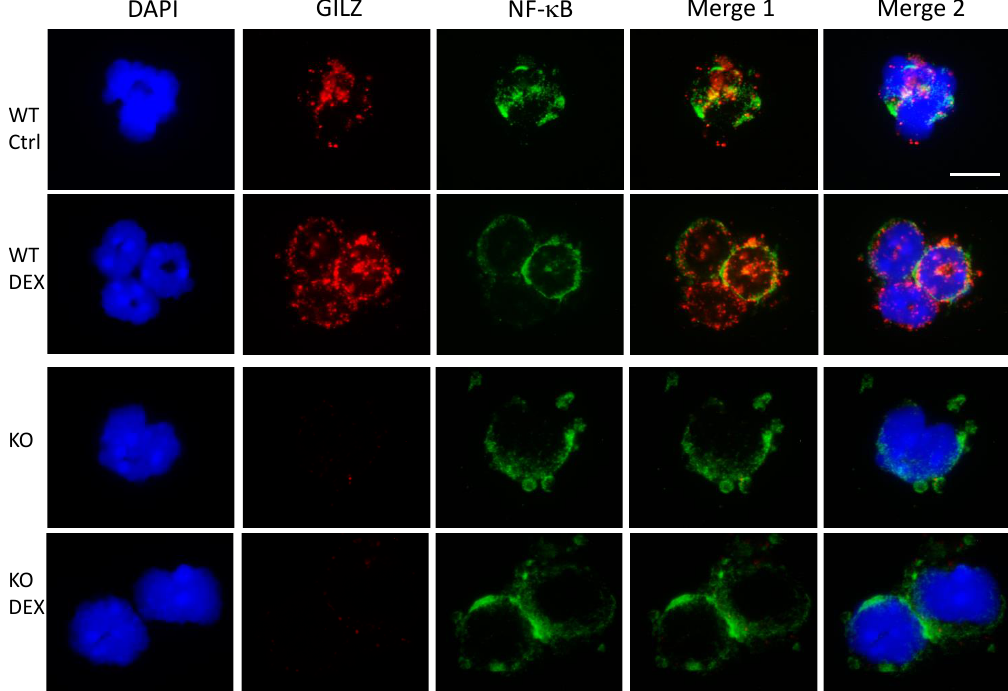
Figure 2. GILZ and NF- κ B staining in mouse neutrophils does not overlap. Isolated peripheral WT and KO neutrophils were spotted on slides after 3h in vivo DEX treatment. Nuclei were stained with diamidino-2-phenylindole (DAPI). Cytoplasmic Figure 2 . GILZ and NF-  B staining in mouse neutrophils does not overlap nuclear factor- κ B (NF- κ B) (green) and GILZ (red) staining did not show overlapping spots (yellow, merge 1) in untreated cells (upper panels) or in DEX-treated cells (middle panels). Overlapping staining of NF- κ B, GILZ, and DAPI is shown in Merge 2. GILZ staining was absent in the KO neutrophils (lower panels). Scale bar: 10 µ m. All experiments were repeated three times. The results of a representative experiment are